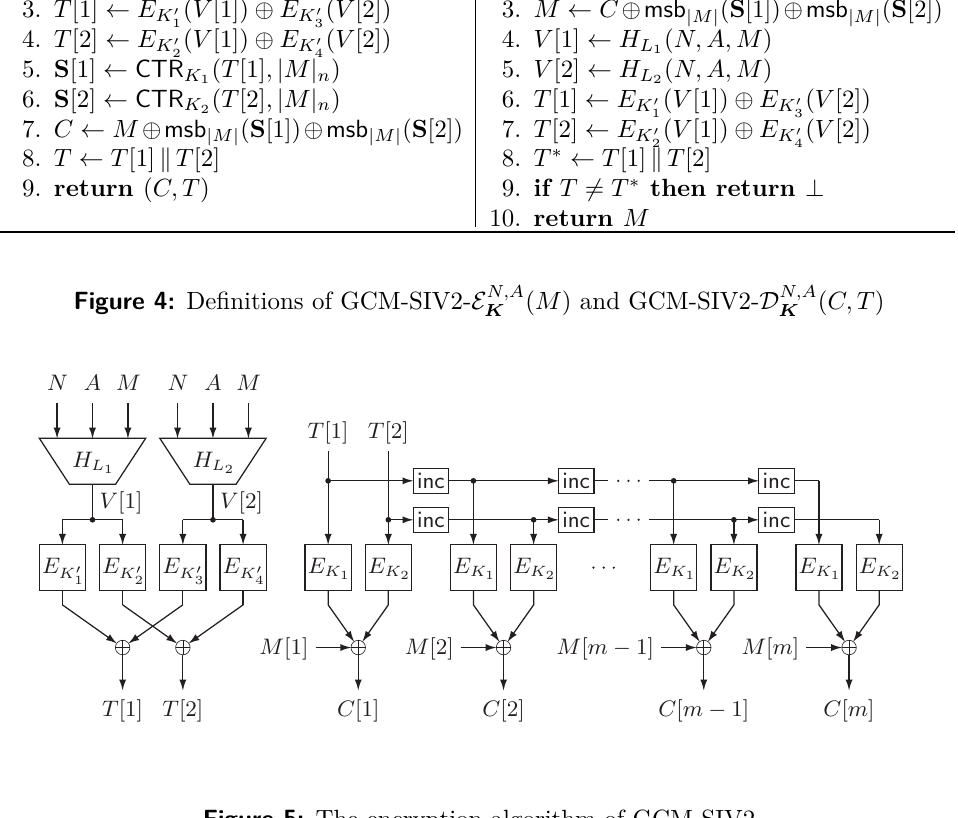
Figure 5: The encryption algorithm of